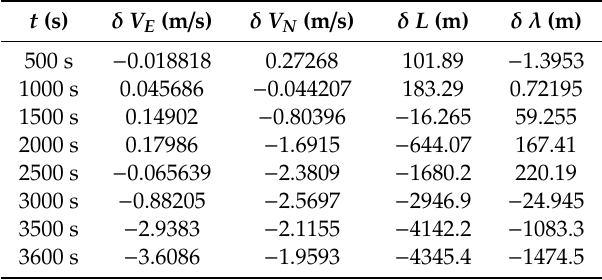
Table 7. Errors of SINS on a vehicle.